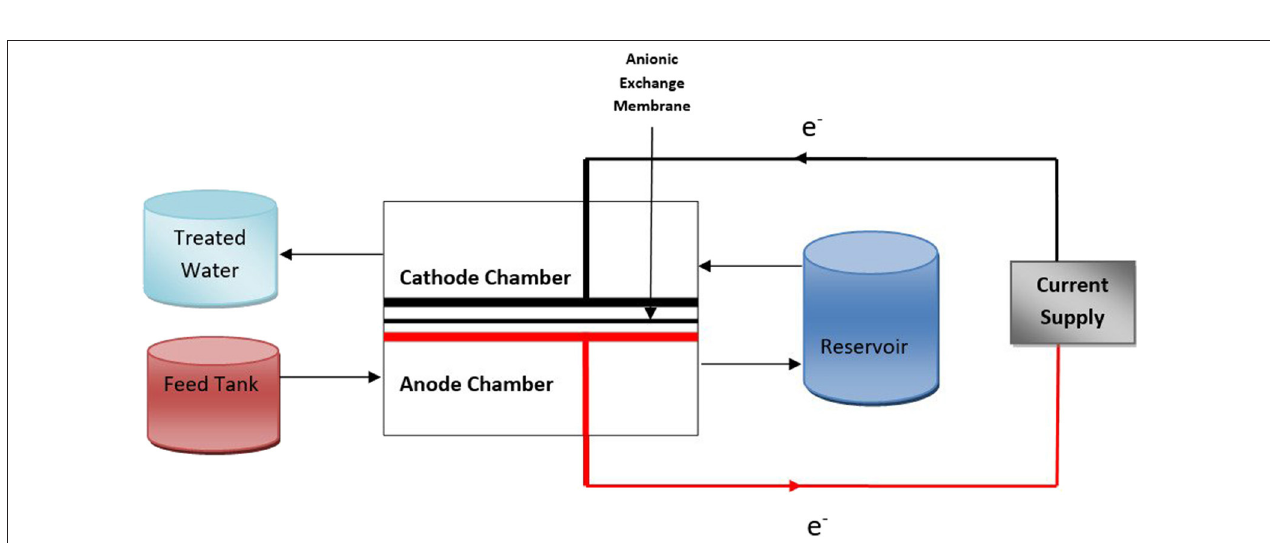
FIGURE 3 | Schematic diagram showing the flow pattern of the feed (VFCW passed septage) through the electrochemical reactor in continuous-AEM W -AC electrolysis experiment.